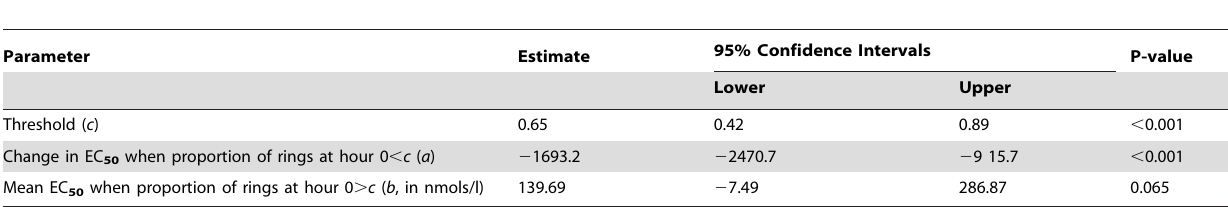
Table 2. Parameter estimates for threshold modelling of the relationship between the proportion of rings samples at hour 0 and CQ EC 50 in P. vivax .